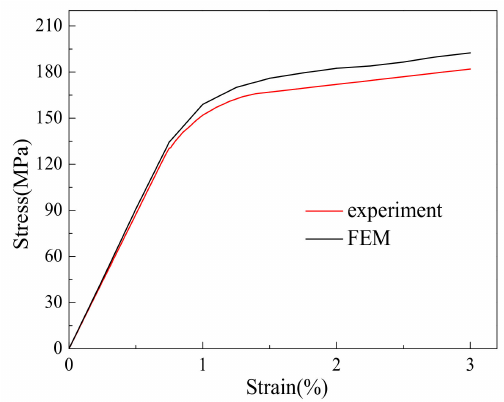
Figure 8. Comparative analysis of stress-strain curves of GRANs between simulation and